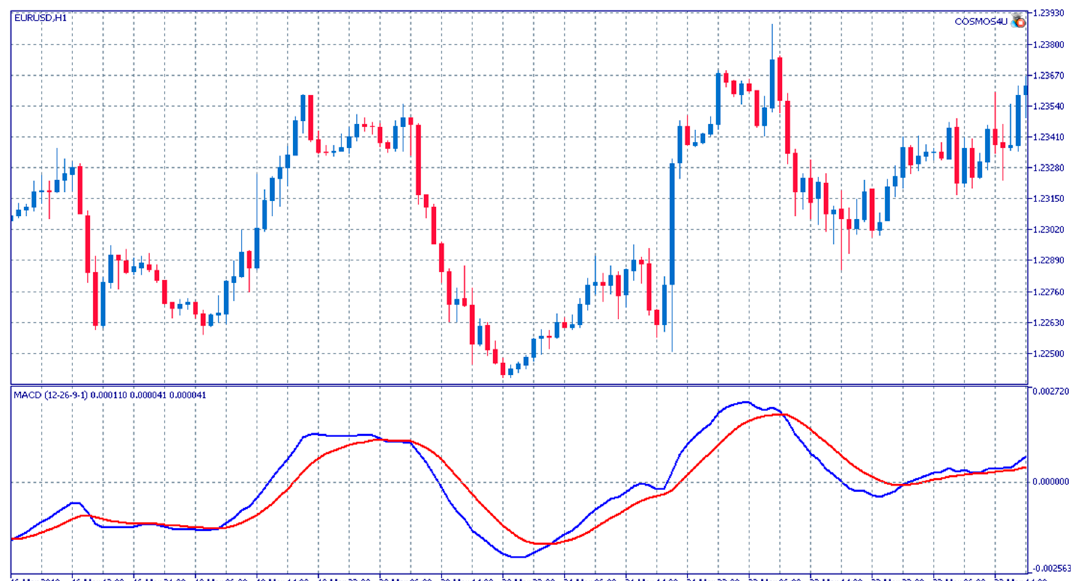
Figure 1. EURUSD chart with an MACD line (blue) and a Signal line (red) below.